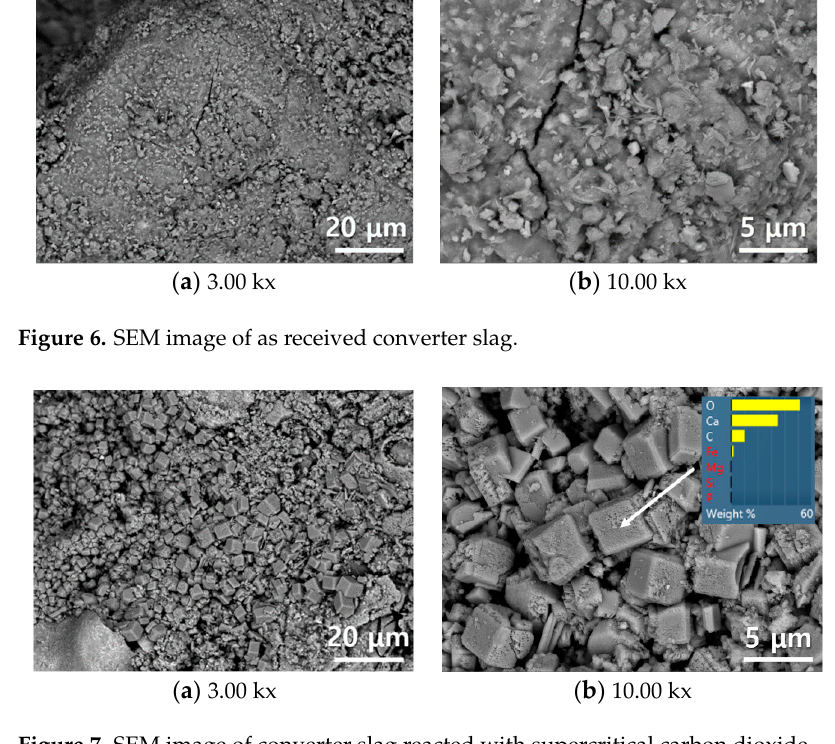
Figure 7. SEM image of converter slag reacted with supercritical carbon